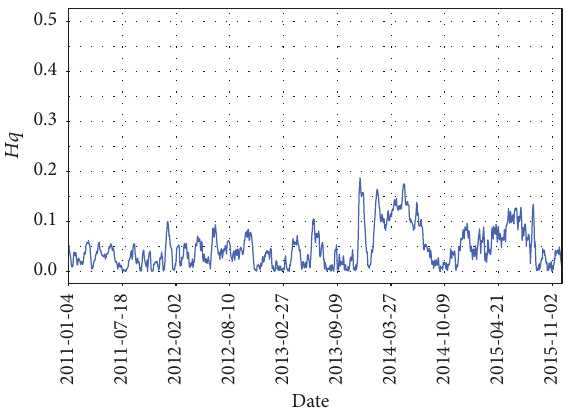
Figure 13: Time varying market inefficiency indices.